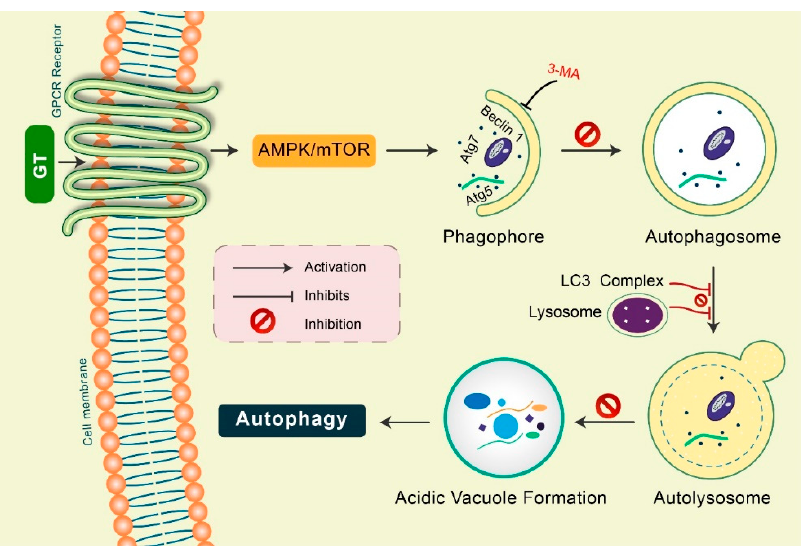
Figure 5. Gintonin (GT) activates autophagy in mouse cortical astrocytes. GT-mediated autophagy was dependent on GPCR-LPA receptors. Pretreatment with an LPA receptor antagonist, Ki16425, considerably decreased GT-mediated autophagy, while LPA agonist pretreatment, LPA 18:1, augmented autophagy in astrocytes. Autophagy initiation proteins Atg5, Atg7, and Beclin-1 were found to be activated in GT-mediated autophagy in astrocytes. Inhibition of autophagy by 3-MA, GT-mediated autophagy was prevented. Pretreated with E-64d/pepstatin A and bafilomycin A1, GT additionally improved LC3 puncta formation indicating enhanced autophagic flux in cortical astrocytes. GT treatment increased acidic vacuole formation along with p62 protein accumulation during this autophagy process. β -elemene: β -elemene, derived from Rhizoma Curcumae, is a natural terpenoid bioactive compound that shows strong activity against various types of cancers [40]. In the human body, β -elemene